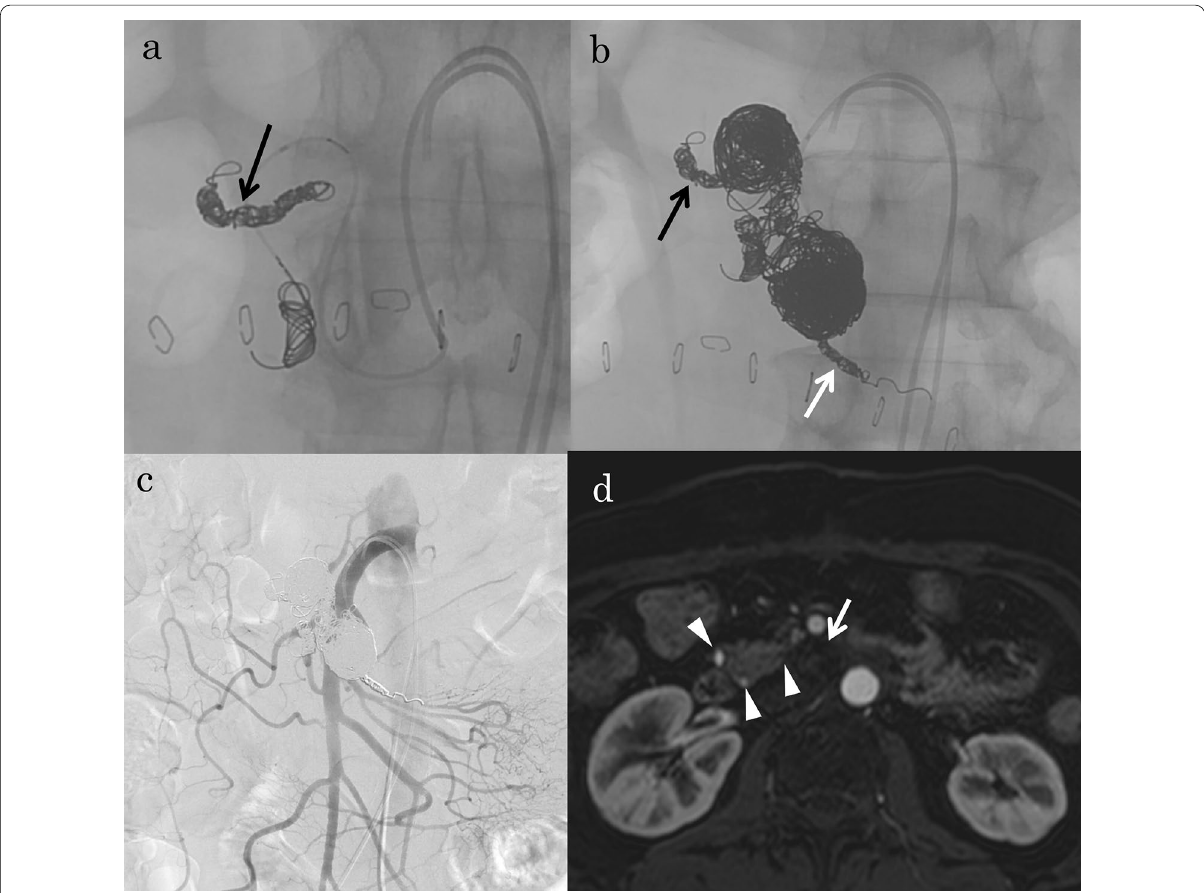
Fig. 4 Images from Case 1. a, b Fluoroscopic images during coil embolization showing embolization of the inferior pancreaticoduodenal artery (PDA) combined with packing of the aneurysms. Additional embolization with coils is shown in the branch of the inferior PDA (black arrows) and first jejunal artery (white arrow) arising from the proximal inferior PDA to prevent reperfusion of the PDA aneurysms (PDAAs). c Post-embolization angiogram via the superior mesenteric artery showing complete occlusion of the aneurysms. d Contrast-enhanced magnetic resonance imaging after treatment showing disappearance of the arterial flow in the proximal PDAA (white arrow) and decreased thickness of the pancreatic arcades (white